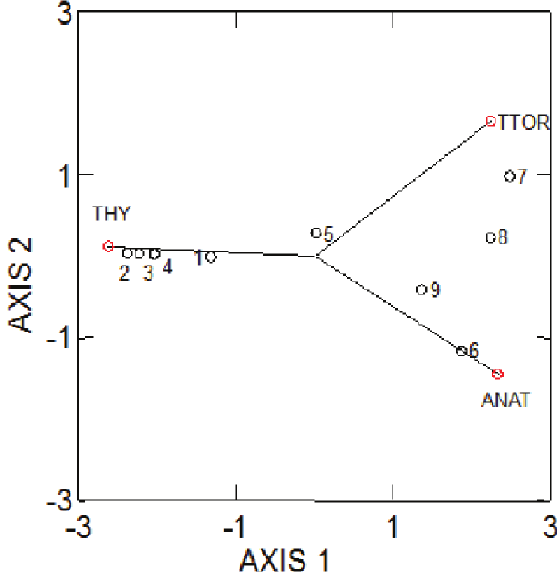
Fig. 5 - Biplot of Squamata species x studied areas of restinga ecosystems on the coast of the State of Bahia, Brazil, using three lizards species Ameivula nativo (ANAT) and Tropidurus torquatus (TTOR) and Tropidurus hygomi (THY) as correspondence analysis fators: 1 = Costa Azul; 2 = Baixio; 3 = Guarajuba; 4 = Abaeté; 5 = Guaibim; 6 = Boipeba; 7 = Cassange; 8 = Taipe; 9 = Nova